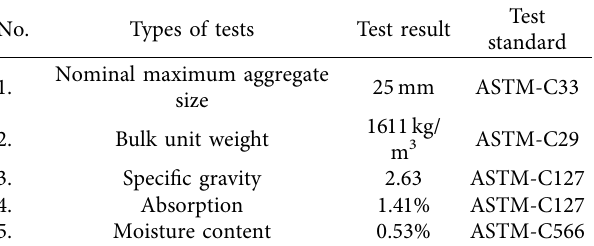
Table 4: Physical properties of coarse aggregate.